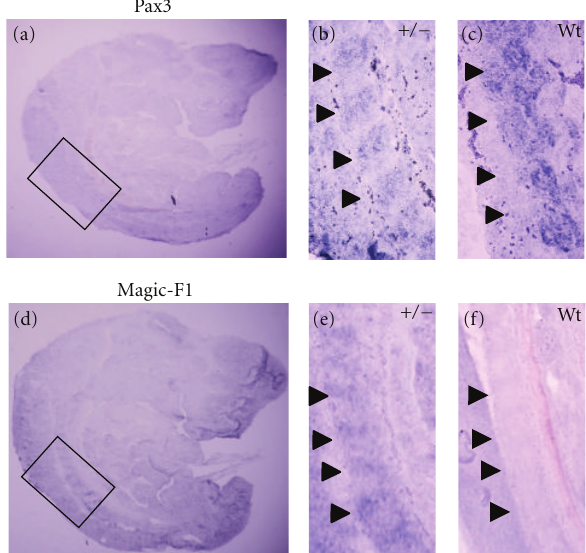
Figure 4: Expression of Pax3 and Magic-F1 in 13.5 dpc mouse embryos. (a) Sagittal section of 13.5 dpc mouse hybridized by Pax3 riboprobes. A weak signal of Pax3 transcripts have been detected in Magic-F1 transgenic embryos (+/ − ) at the level of somites in thoracic (b) and lumbosacral region; in the wild-type age-matched embryo (wt) the signal appeared slightly stronger (c). A faint signal was detected at the same stage in transgenic embryos hybridized by Magic-F1 antisense riboprobes (d); mainly, the transgenic expression was localized at the level of somites as shown at higher magnification in (e). No signal was detected in wild type embryos (wt) by Magic-F1 antisense riboprobes (f). Arrowheads show